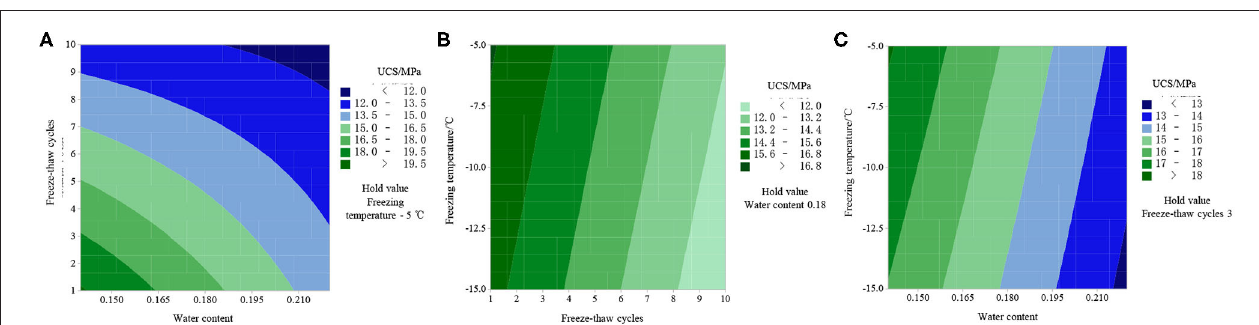
FIGURE 7 | Isoline between UCS of sandstone–concrete complex and factors A , B , and C . (A) Isoline between UCS and factors A , B ; (B) isoline between UCS and factors B , C; (C) isoline between UCS and factors A , C